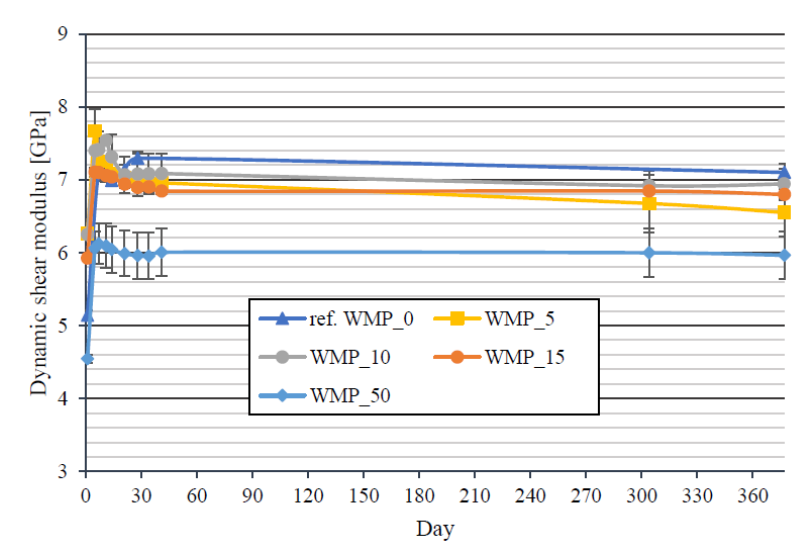
Figure 3. Time dependence of dynamic shear modulus (with standard deviation).